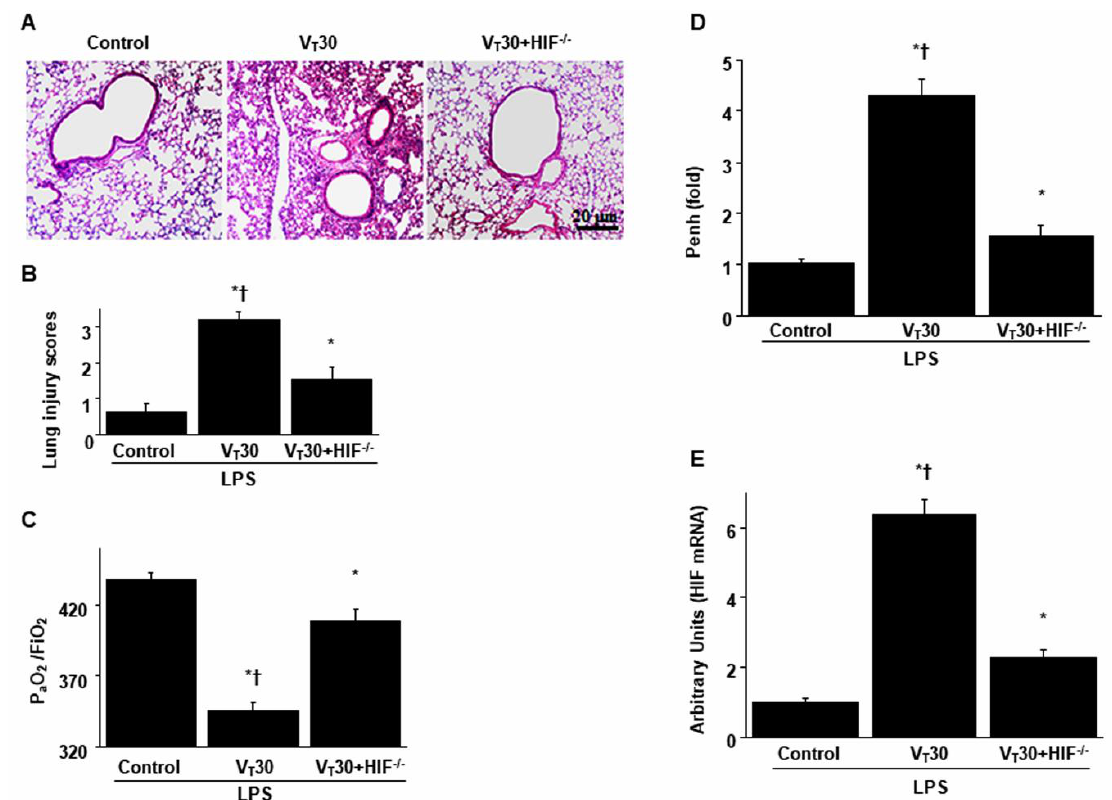
Figure 6. Reduction of endotoxin-aggravated mechanical ventilation-mediated lung damage, hypoxemia, impaired respiratory function and HIF-1 α mRNA expression by HIF-1 α homozygous knockout. ( A ) Histological examination (100 × ), ( B ) lung injury scores, ( C ) PaO 2 / FiO 2 , ( D ) enhanced pause and ( E ) HIF-1 α mRNA expression were from the lungs of nonventilated control mice and those subjected to a tidal volume of 30 mL / kg for 5 h with or without LPS administration ( n = 5 per group). ( D ) Real-time polymerase chain reaction of HIF-1 α mRNA expression was from the lungs of nonventilated control mice and those subjected to tidal volume at 6 or 30 mL / kg for 5 h with LPS administration ( n = 5 per group). Arbitrary units were expressed as the ratio of HIF-1 α mRNA to GAPDH ( n = 5 per group). Scale bars represent 20 µ m. * p < 0.05 versus the nonventilated control mice with LPS treatment; † p < 0.05 versus HIF-1 α -deficient mice.